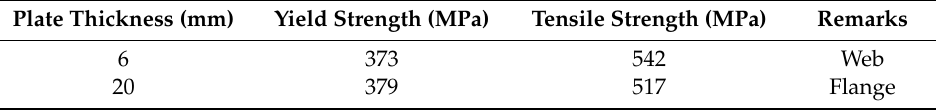
Table 2. Basic mechanical properties of the material, data from [38].